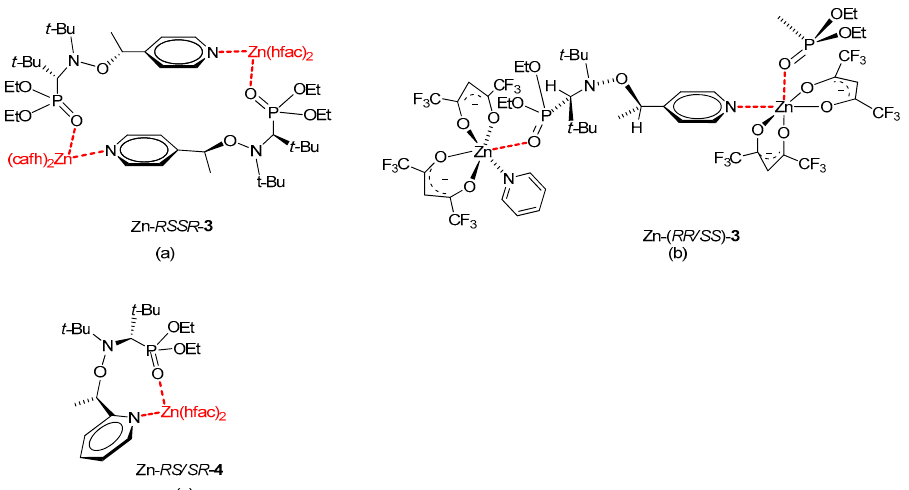
Figure 9. Structures of bis(hexafluoroacetylacetonate) zinc complexes with alkoxyamines 3 and 4 according to X-ray diffraction data: ( a ) the ring-type complex, ( b ) chain-type complex, and ( c ) intramolecular complex. The structure of the complex depends strongly on the diastereomeric configuration of the alkoxyamine. Materials 2018 , 11 , x FOR PEER REVIEW 11 of 21